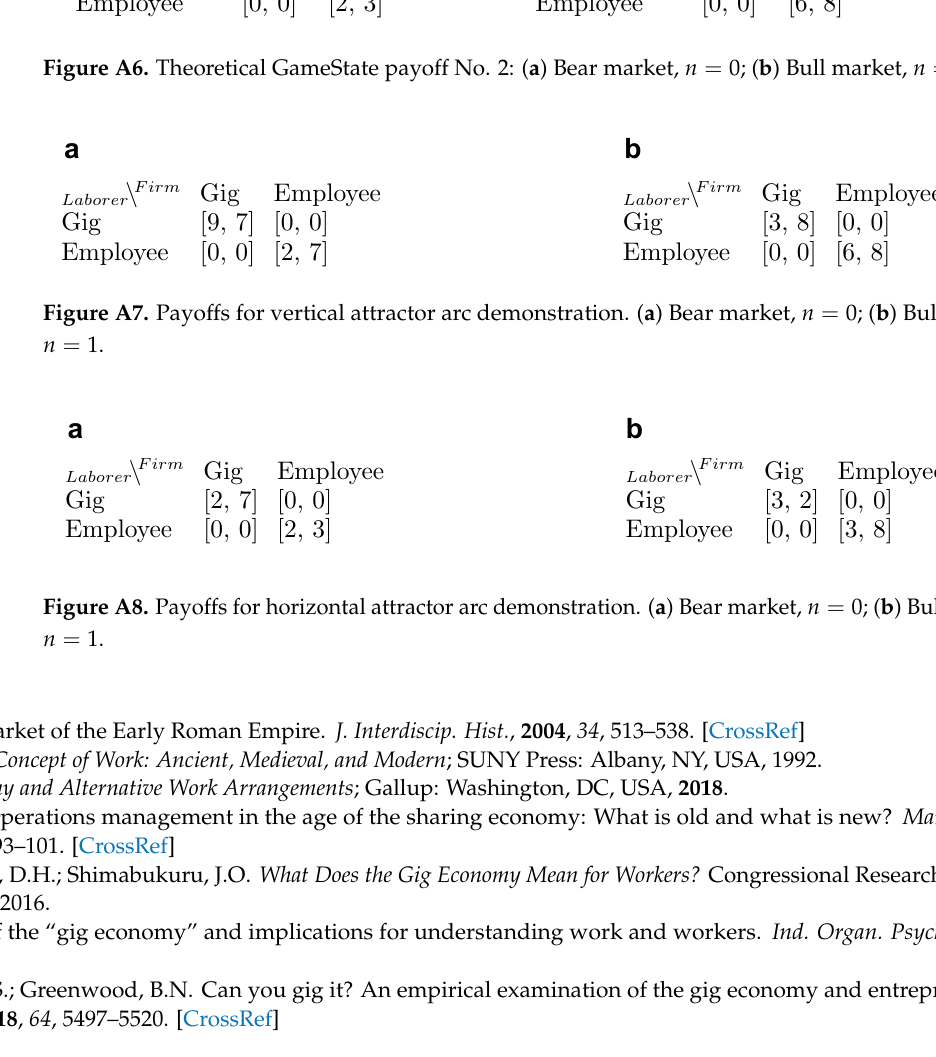
Table 10 2x2 Payo↵ Matrix for GameState in Setting Large High Bull